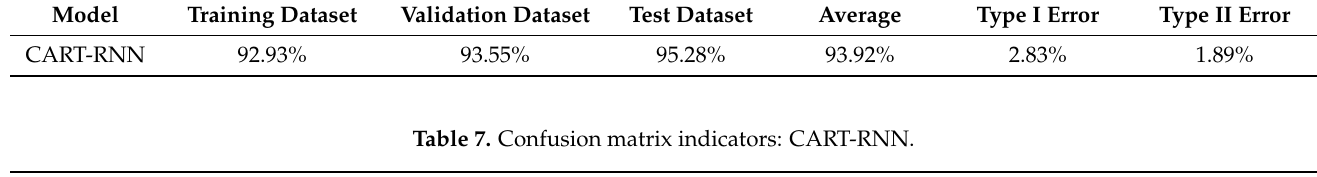
Table 6. Accuracy of the CART-RNN model.